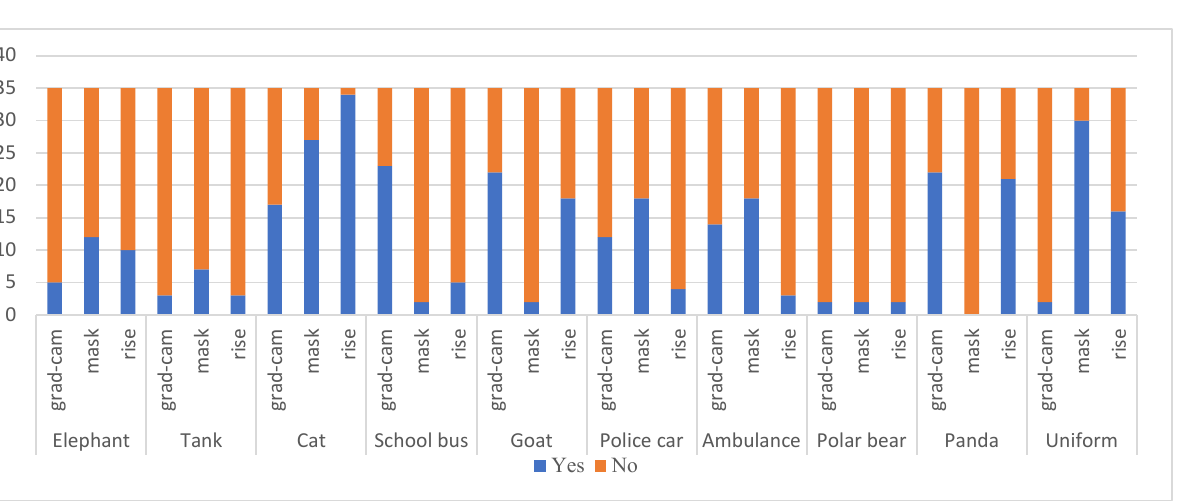
Figure 11. For different interpretation algorithms under top-3% occlusion, the statistical results of object names that users can identify. Each interpretation method is tested with 10 images from DataS and 35